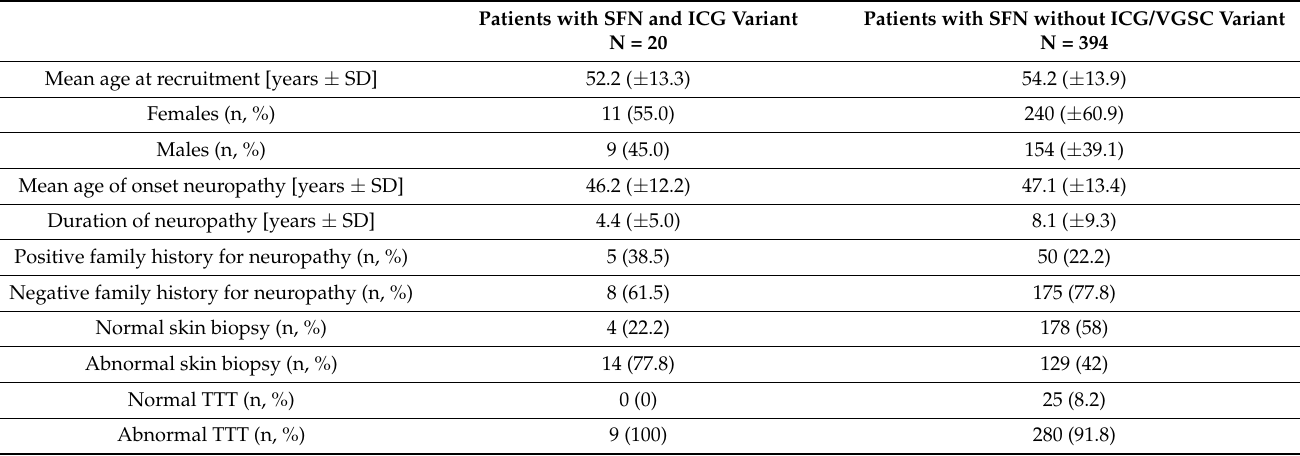
Table 2. Comparison of clinical features of patients with small fiber neuropathy and ICG variant vs. no ICG/VGSC variant.